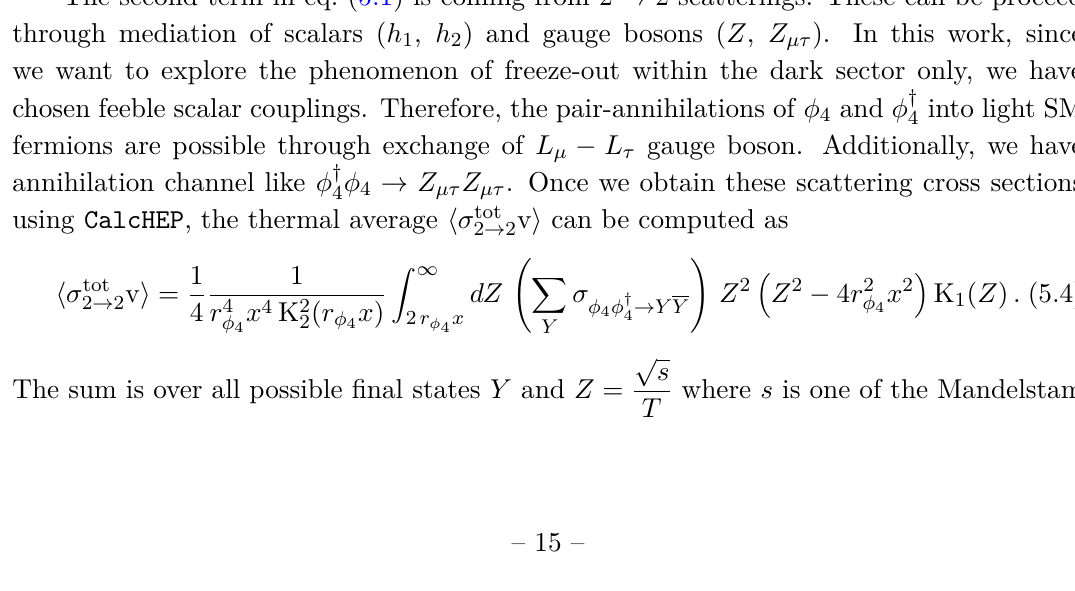
Figure 3 . Feynman diagrams for the 3 → 2 scattering φ 4 φ 4 φ 4 → φ 4 φ † density of φ decreases by 2 unit per 4